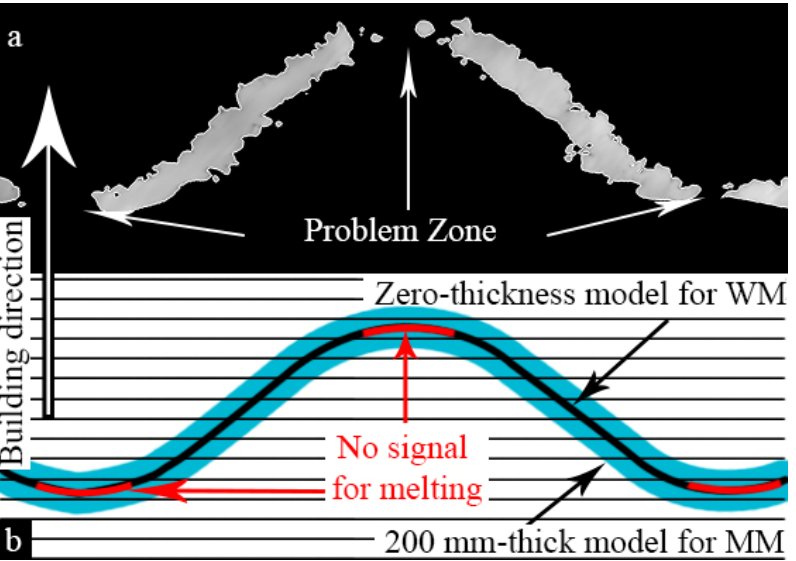
Figure 10. Assumption on the through-holes’ appearance: ( a ) CT in vertical cross-sectional view; ( b ) Scheme of manufacturing process in vertical cross-sectional view.